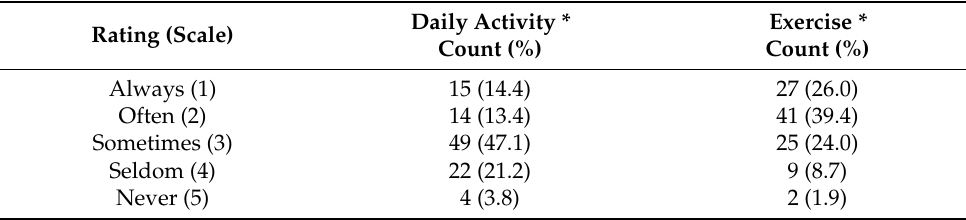
Table 4. Perceived breathability (PB) measure with the extent of disturbance to breath. Daily Activity * Rating (Scale)